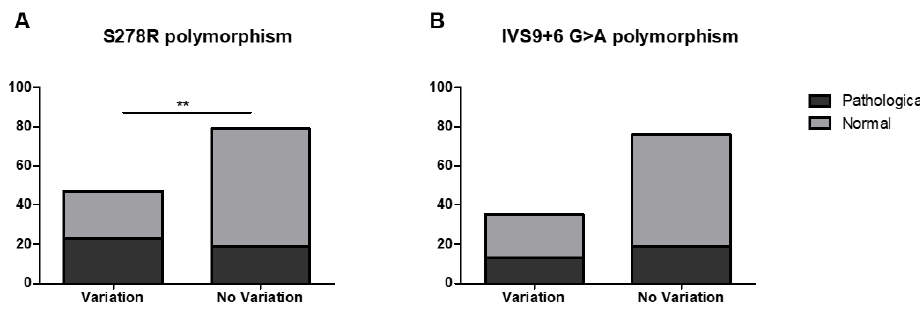
Figure 2. Statistical analysis ( χ 2 test) of differences in the prevalence of AIRE gene polymorphism in patients with APECED-like versus controls. ( A ) Prevalence of the S278R polymorphism in n = 23 patients out of the total n = 48 and controls. Statistically significant difference was observed, ** p < 0.05. ( B ) Prevalence of the IVS9+6 G>A intronic polymorphism in n = 13 patients of the total n = 48 versus controls. No statistically significant difference was observed.